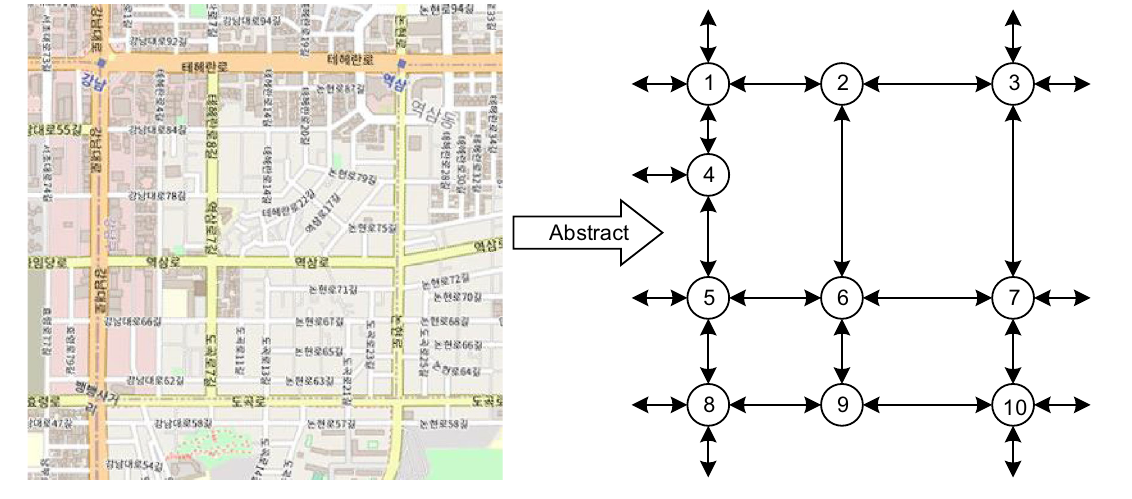
Fig. 2 Graph representation of traffic network